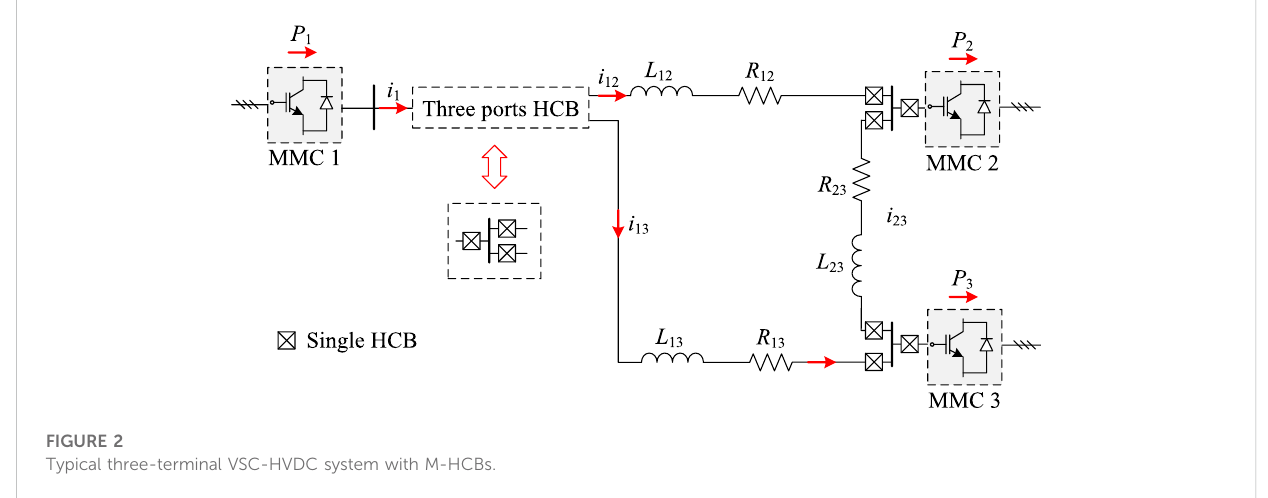
FIGURE 2 Typical three-terminal VSC-HVDC system with M-HCBs.